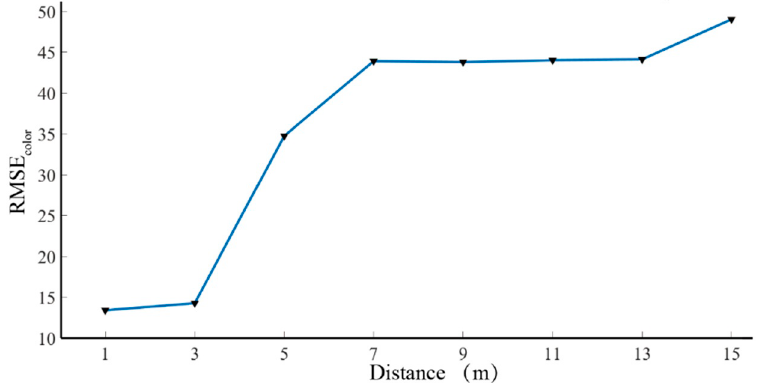
Figure 9. RMSE color (calculated by using Equation (6)) versus the T-C distances.